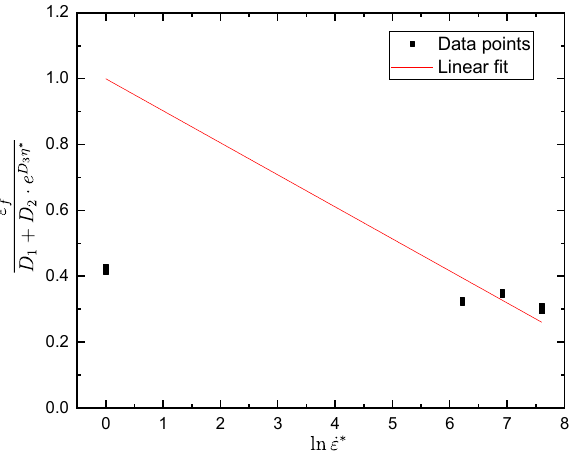
. ∗ ε and ln based on fracture point D 1 + D 2 · e D 3 η ∗